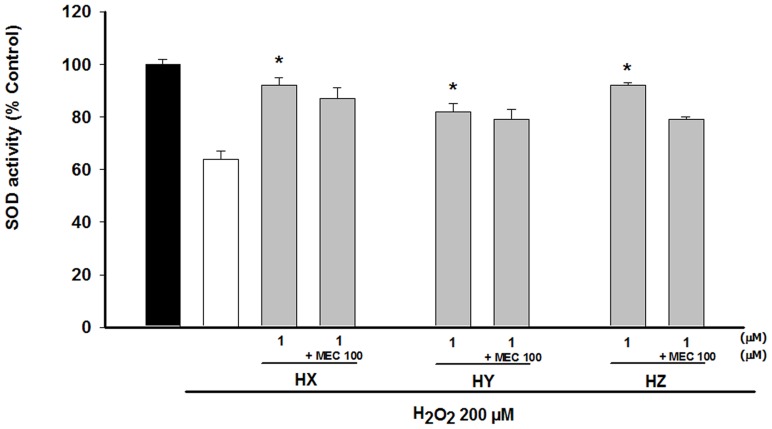
Modulation of the SOD activity in NGF-PC12 differenciated cells by HX, HY and HZ.Huprines were added alone or concomitantly with MEC (100 µM) to the culture 48 h prior to H2O2 addition. Then, cells were incubated with 200 µM H2O2 for 2 h. SOD activity was measured using a SOD activity assay from Fluka. At least three independent experiments were carried out in triplicate. The data are means ± s.e.m. expressed as percentage of control value. *p<0.05 compared with H2O2 group (Dunnett's test).